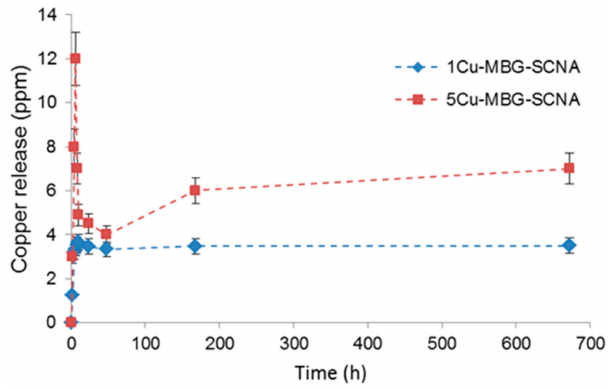
Figure 10. Profiles of copper release from 1Cu-MBG-SCNA and 5Cu-MBG-SCNA scaffolds following immersion in